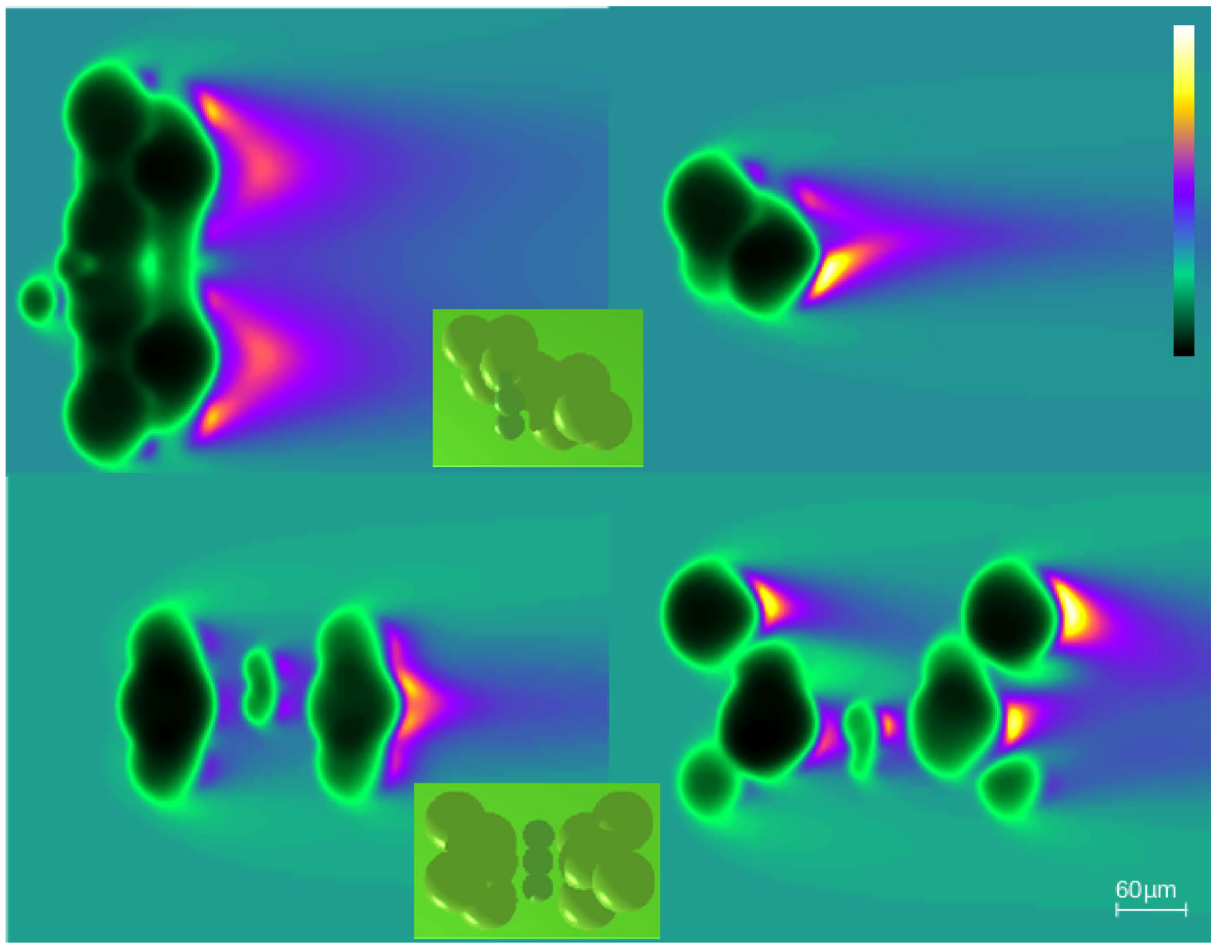
Figure 4. Two complex water bubble distributions (left: “xz” planes, right: “yz” planes).